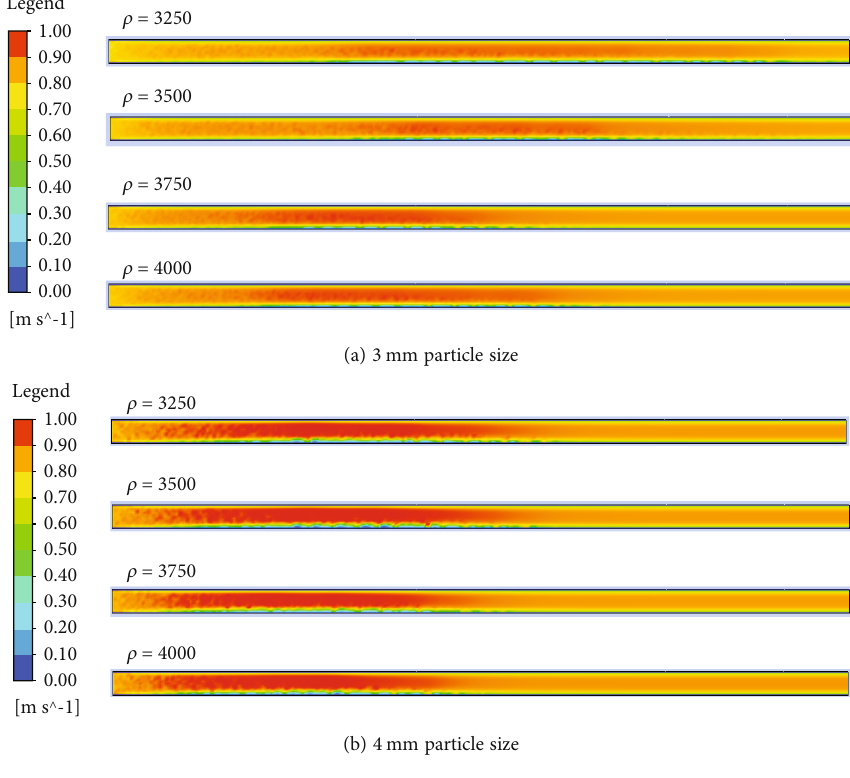
Figure 7: Cloud map of fl uid velocity with 3mm and 4mm aggregate.